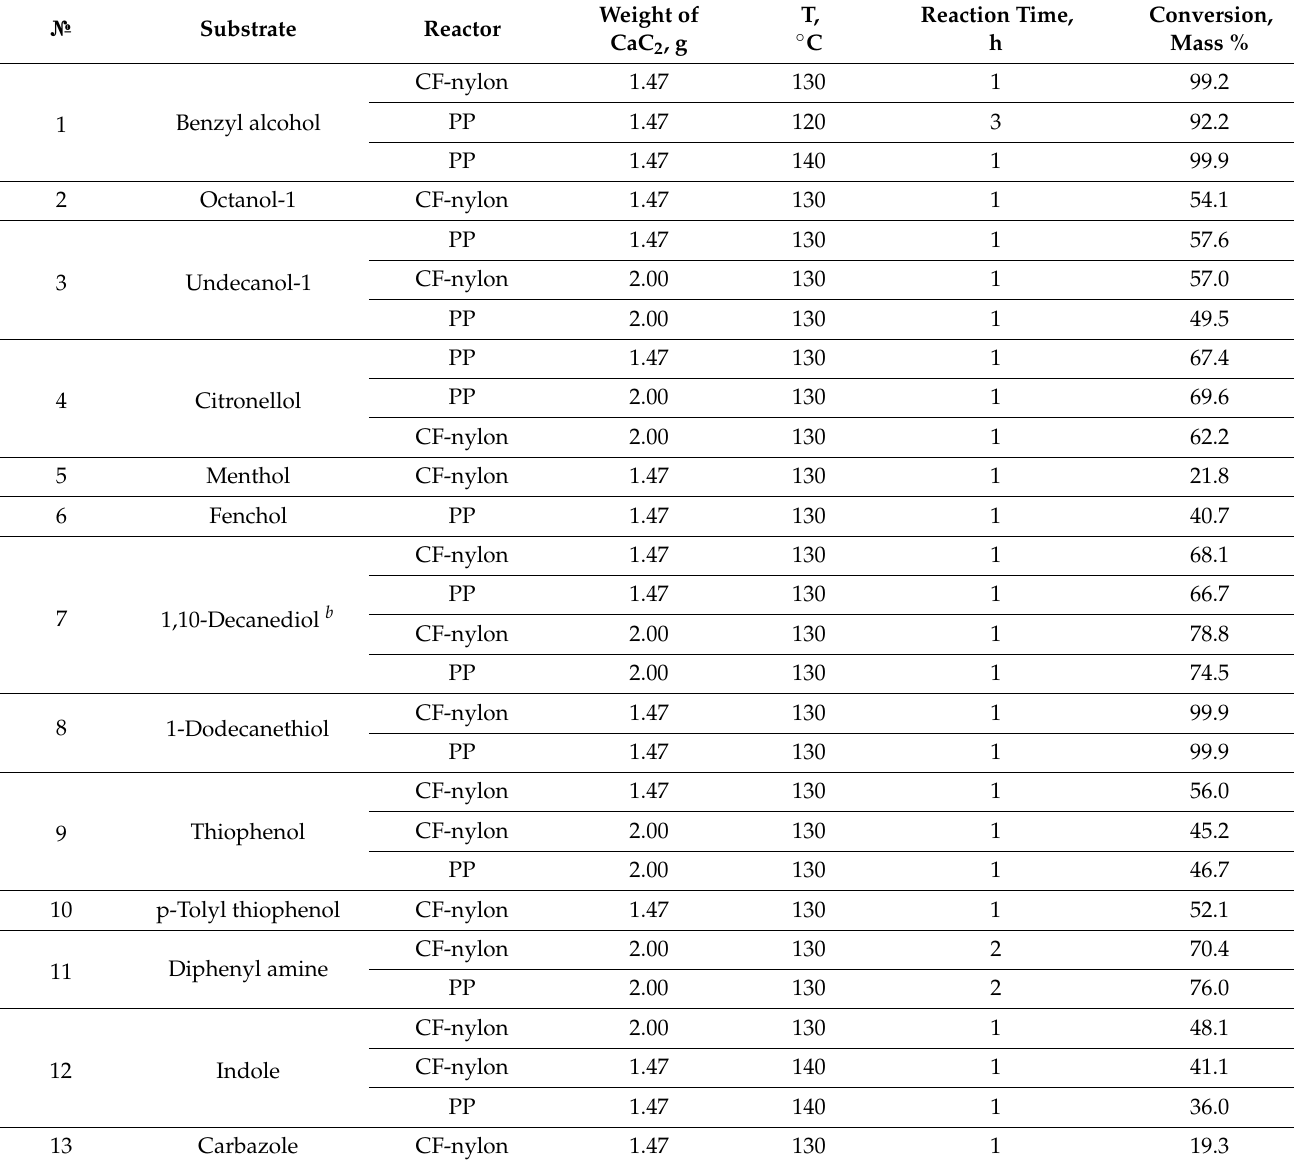
Table 4. Reaction conditions and product yields of the synthesized vinyl derivatives a